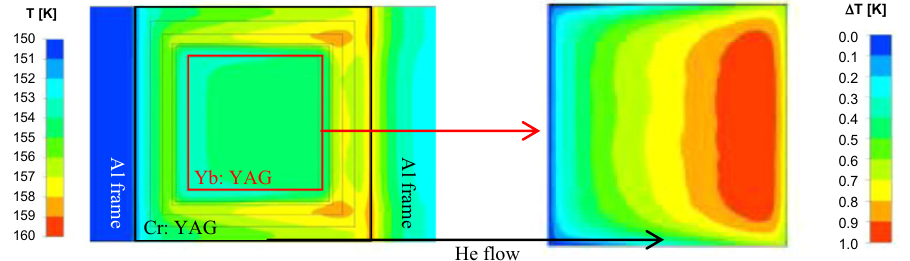
Figure 3. Temperature map of the surface of the Yb:YAG laser slab including the Cr:YAG absorption layer (on the left) and zoomed region of active surface of Yb:YAG (on the right) used for amplification of the laser beam that is propagating perpendicularly to the plane of the